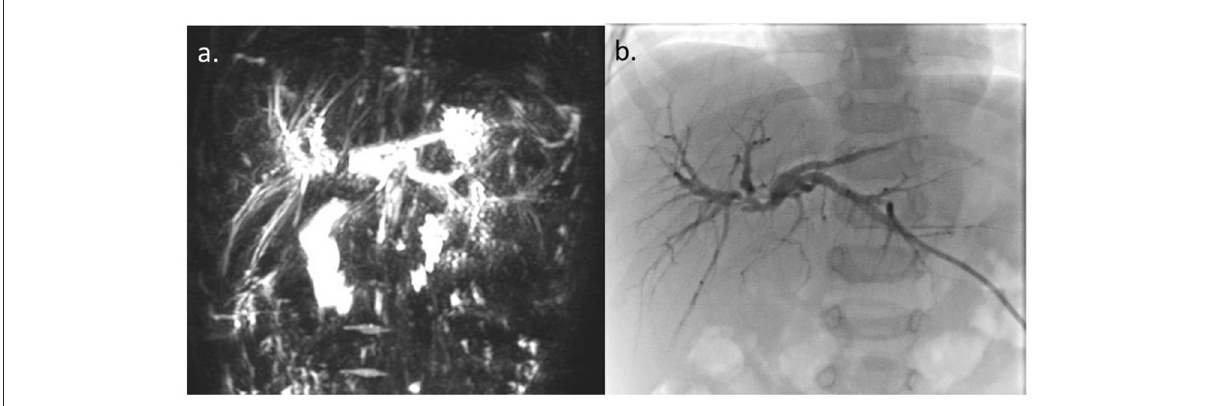
by Filipin staining of unesterified cholesterol. Fluorescent spot corresponding to LpX on the gel was monitored by ChemiDoc (BioRad,Hercules,CA,USA)